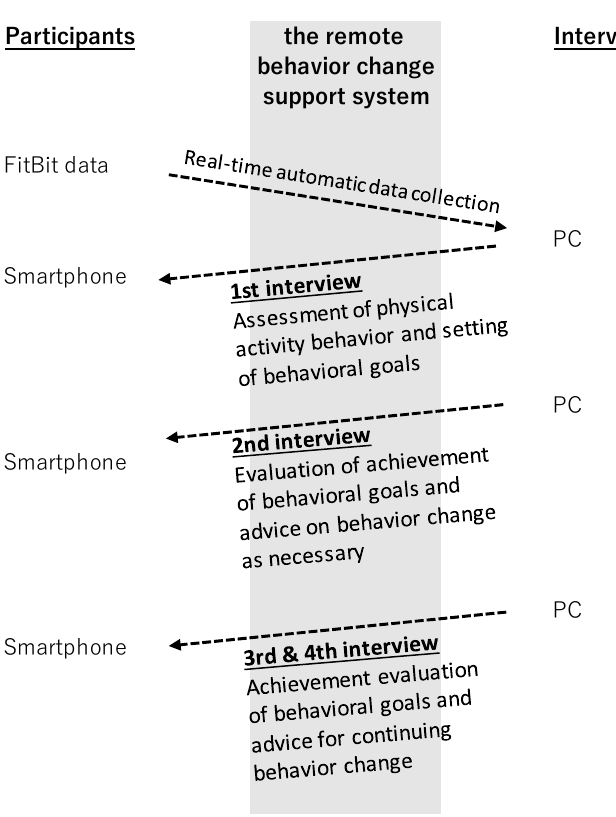
Figure 2. The content/structure of the behavior change interviews.